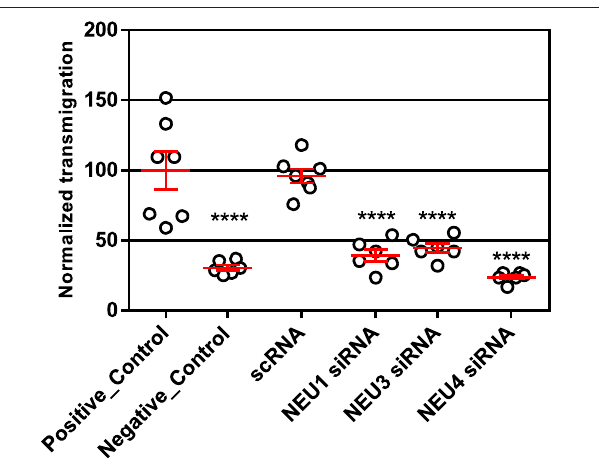
FIGURE 2 | Transmigration of cells after NEU1, NEU3, and NEU4 knockdown. Transmigration experiments were carried out with a FN-coated transwell plate 21 h after knockdown treatment. The bottom chamber was loaded with serum and cytokine-free media as an untreated control (positive control); CytoD was used as a negative control for transmigration. All other experiments used a lower chamber containing cytokine and serum as attractant. Cells were allowed to transmigrate for 21 h and were counted by fl ow cytometry. Data shown are for six (Tiemeyer et al., 1991) replicates (3 replicatesover twoexperiments);representedasmean±SEMandcompared to scrambled control using a One-way ANOVA followed by Dunnett ’ s post- hoc analysis (**** p ≤